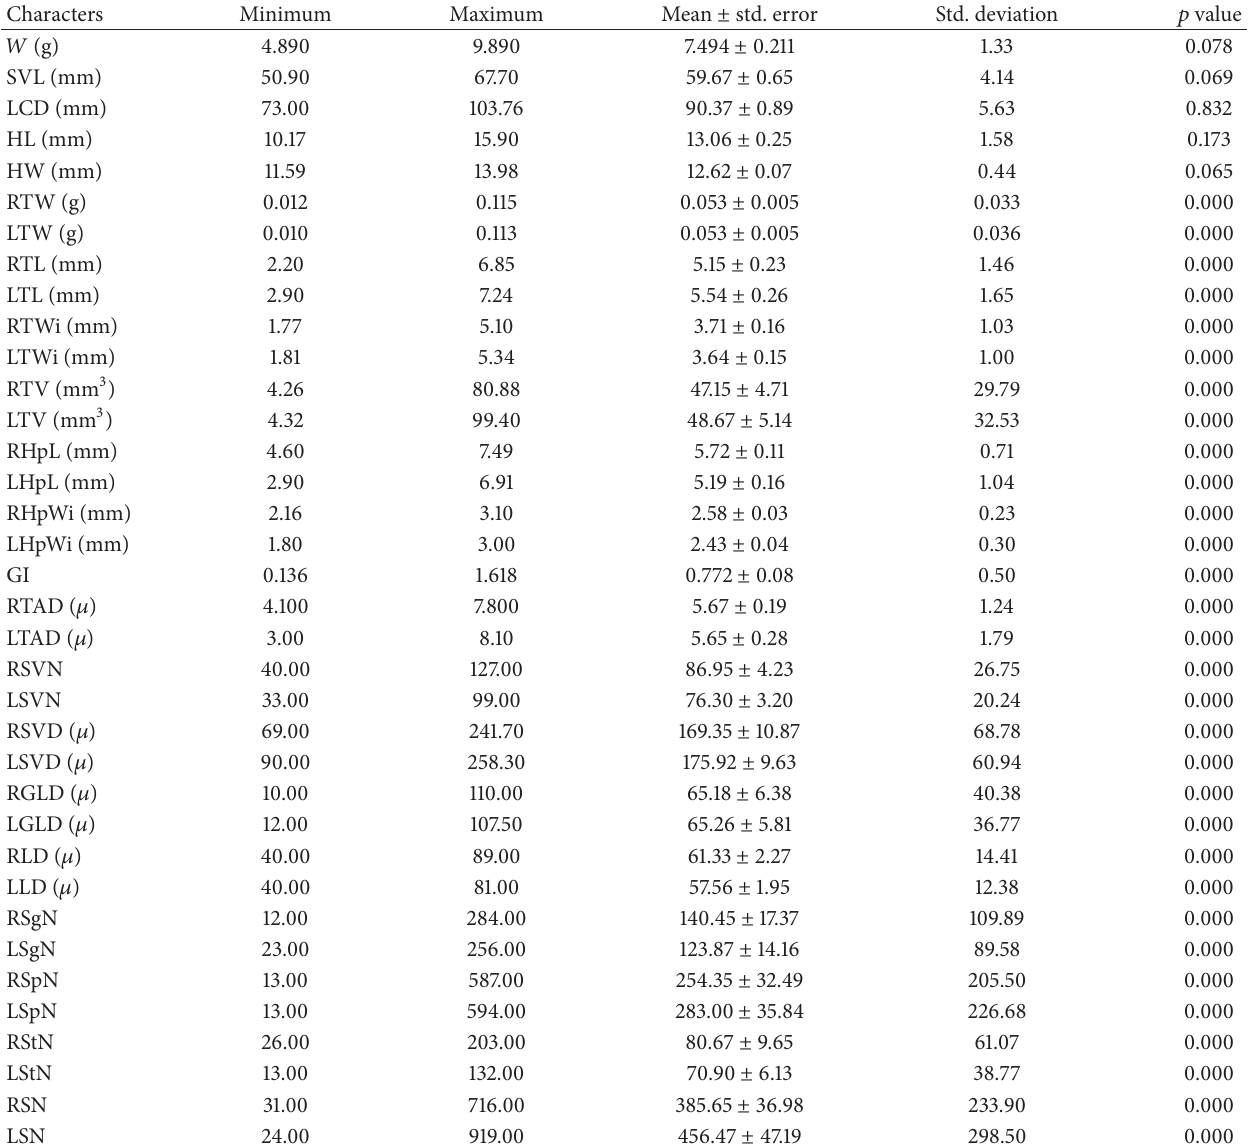
Table 1: Descriptive statistics of macroscopic characters in Phrynocephalus maculatus ( 𝑁 = 40